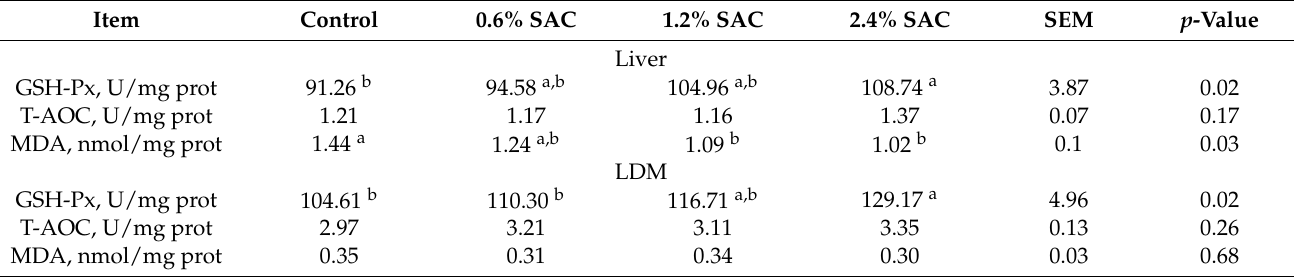
Table 9. Effect of dietary Selenium Auricularia cornea culture supplementation on liver and LDM antioxidant status of growing-finishing pigs.